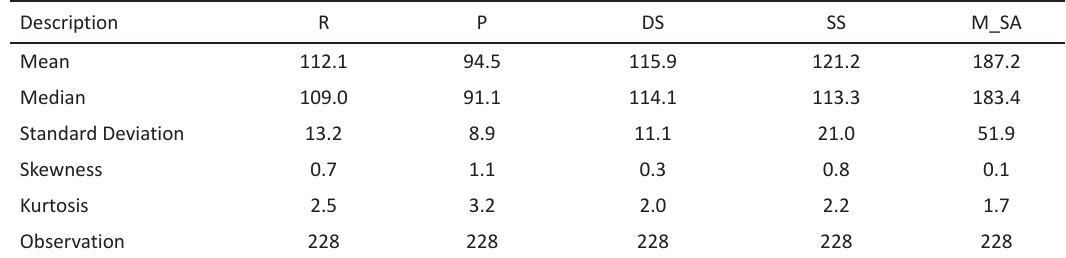
Table 1. Descriptive statistics for the index series